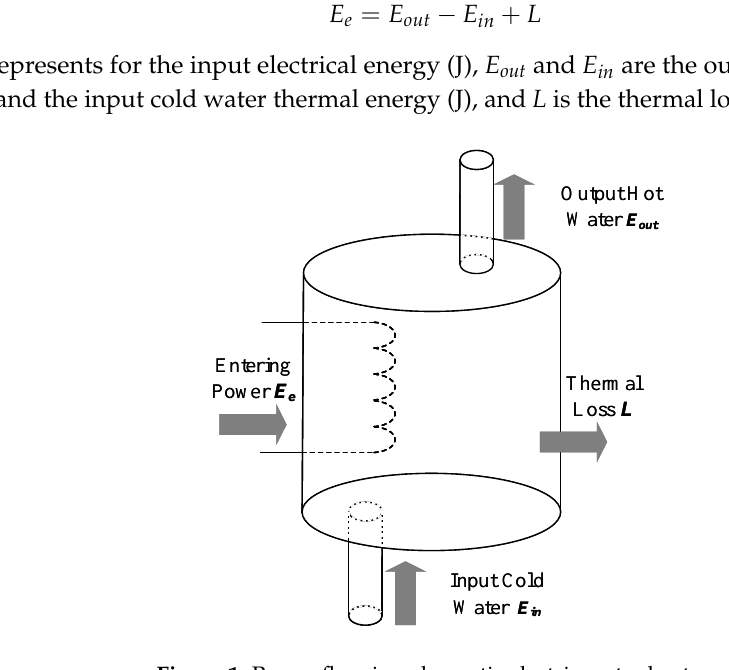
Figure 1. Power flow in a domestic electric water heater.